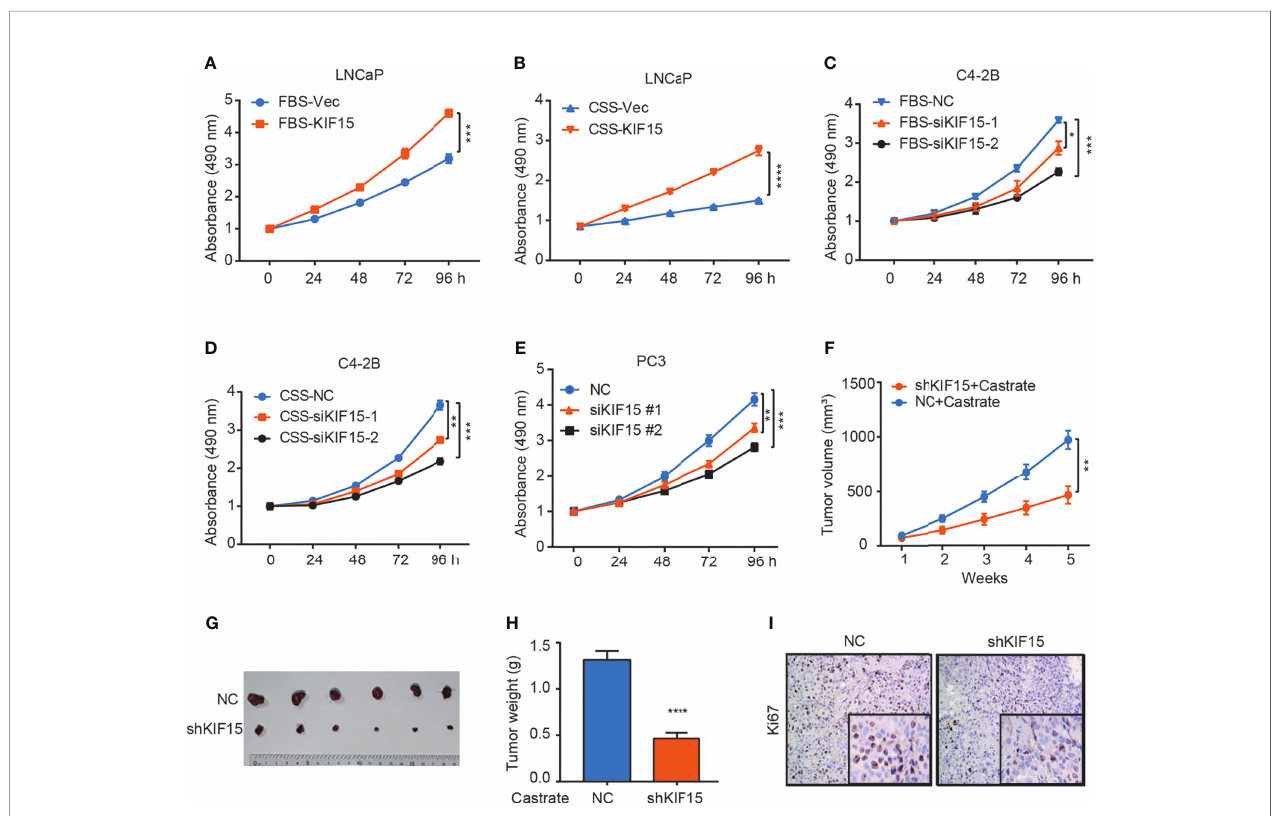
FIGURE 2 | KIF15 promotes CRPC in vitro and in vivo . (A, B) Cell proliferation of LNCaP cells with FBS or CSS treatment assessed by MTS assays. LNCaP cells were cultured in FBS medium (A) or CSS medium for 48 hours (B) , these cells were transfected with corresponding siRNA and subjected to MTS assays. Vec, vector. *** P < 0.001; **** P < 0.0001. (C, D) Cell proliferation of C4-2B cells with FBS or CSS treatment assessed by MTS assays. C4-2B cells were cultured in FBS medium (C) or CSS medium for 48 hours (D) , these cells were transfected with corresponding siRNA and subjected to MTS assays. NC, negative control; * P < 0.05; ** P < 0.01; *** P < 0.001. (E) Cell proliferation of PC3 cells assessed by MTS assays. PC3 cells were transiently transfected with corresponding siRNA, the cells were subjected to MTS assays. ** P < 0.01; *** P < 0.001. (F – H) Xenograft tumor growth after KIF15 depletion. C4-2B cells with stable KIF15 knockdown or its control were injected subcutaneously into nude mice (6 mice per group). Tumor size was measured twice every week (F) . At the endpoint, tumors isolated from euthanized mice were photographed (G) and weighed (H) . ** P < 0.01; **** P < 0.0001. (I) Representative images of Ki67 IHC staining of xenograft tumor derived from C4-2B NC/ shKIF15